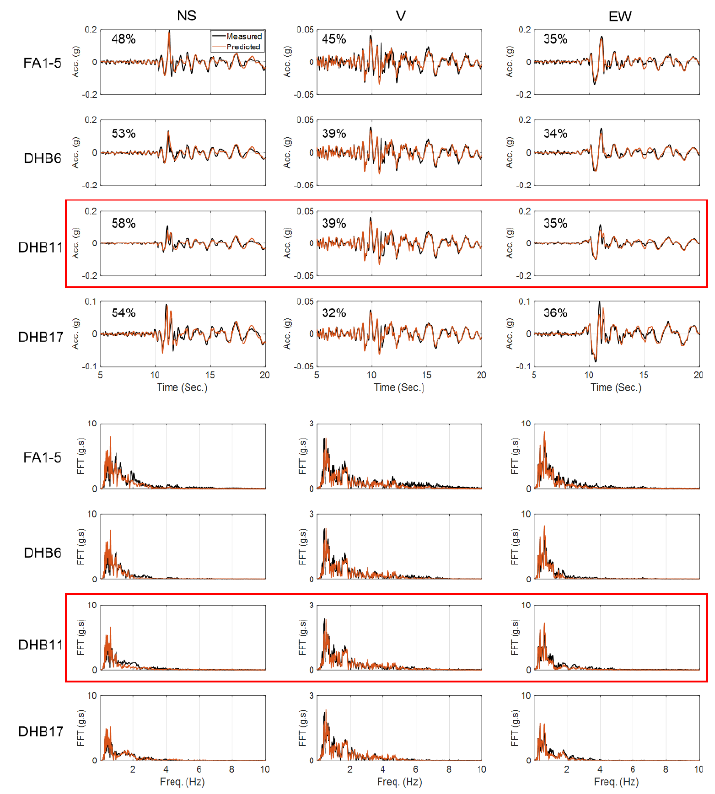
Figure 19. Time-domain ( top ) and frequency-domain ( bottom ) comparison between the recorded and predicted acceleration responses at four depths and in three directions. The recorded responses at depth 11 m (DHB11) are not used in the model updating and are here retained for cross-valida- tion.